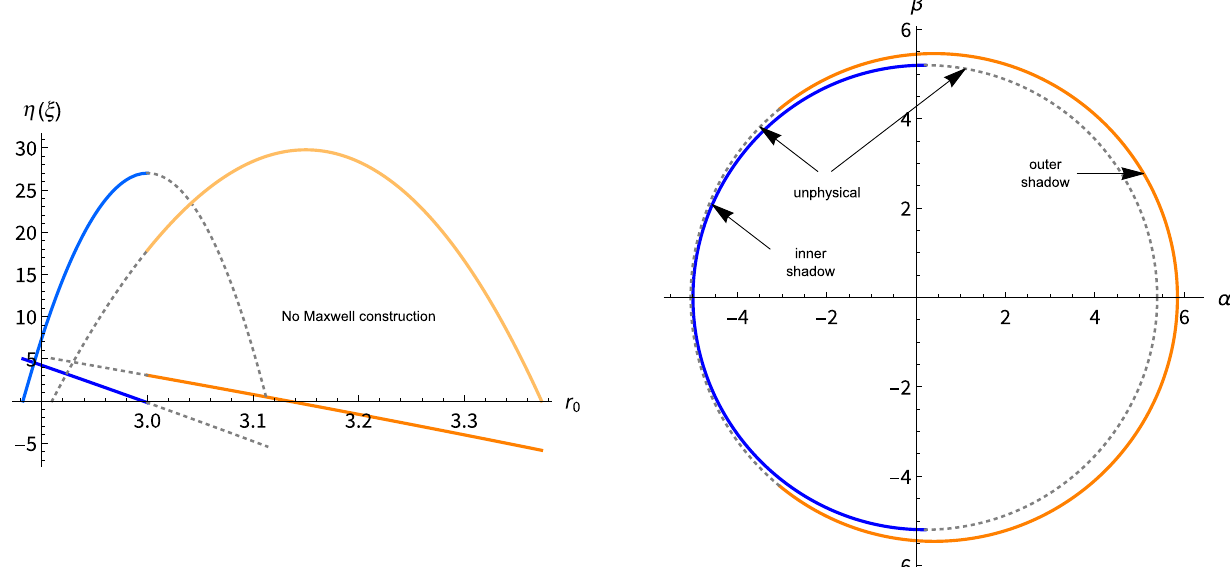
Fig. 3 The fractured black hole shadow is featured by two (mostly disconnected) sections. We adopt the same convention for the line types and colors as Fig. 1. Left: No Maxwell construction can be established for this case. Right: The resultant black hole shadow edge, shown in solid curves, is apparently